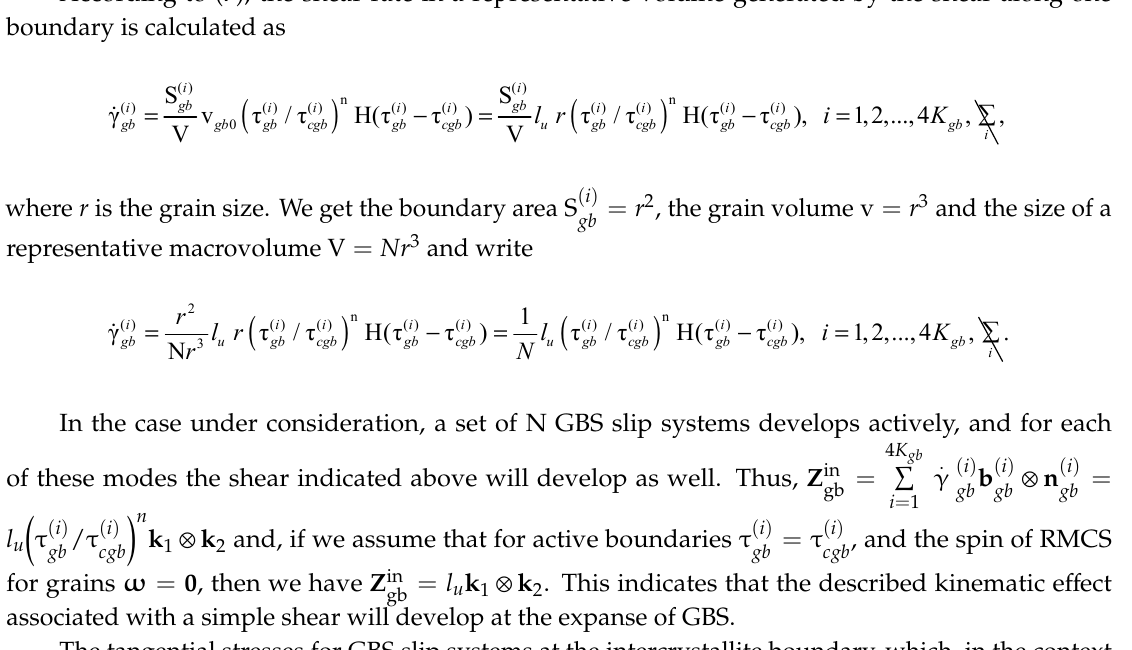
Figure 2. Test case scheme. In statistical sampling the upper grains are considered to be bordering the lower grains.